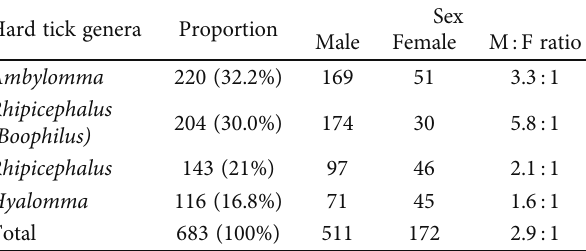
Table 2: Distribution and sex ratio of adult ixodid ticks genera identi fi ed in the Areka